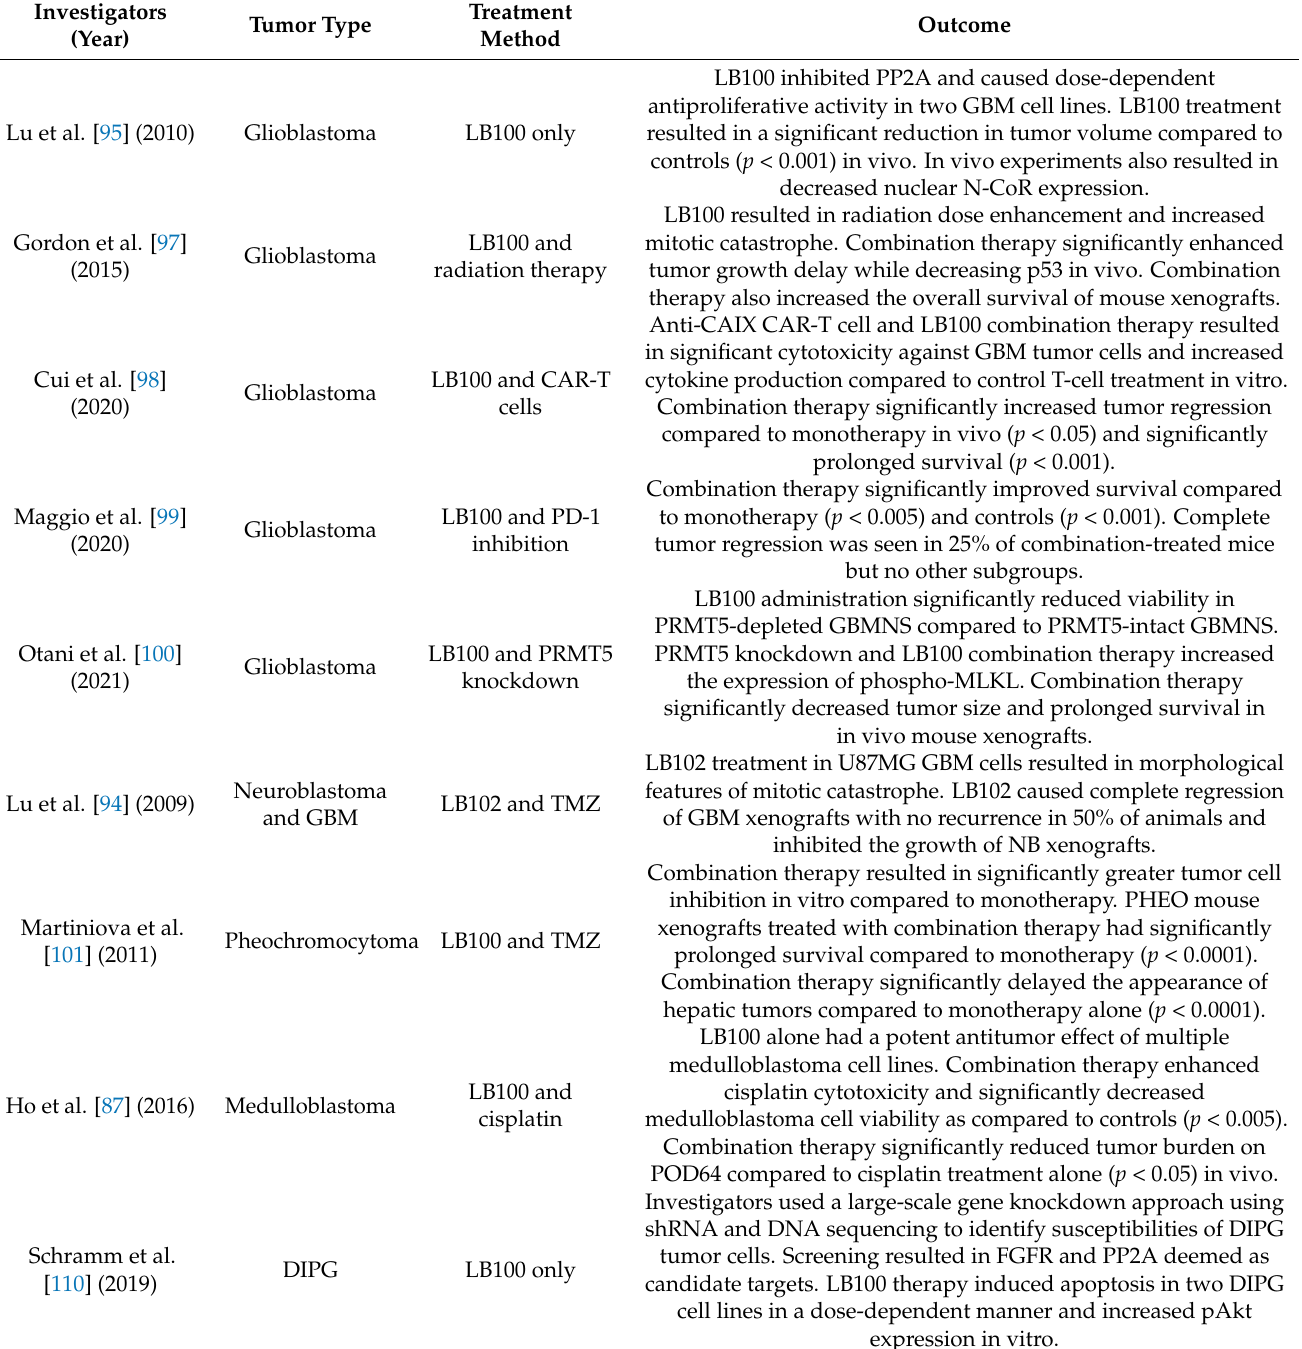
Table 2. Overview of reviewed studies involving the use of LB100 as monotherapy or combination therapy against tumors of the nervous system. CAIX = Carbonic Anhydrase IX; CAR = Chimeric Antigen Receptor; DIPG = Diffuse Intrinsic Pontine Glioma; FGFR = Fibroblast Growth Factor Receptor; GBM = Glioblastoma; NB = Neuroblastoma; NCoR = Nuclear